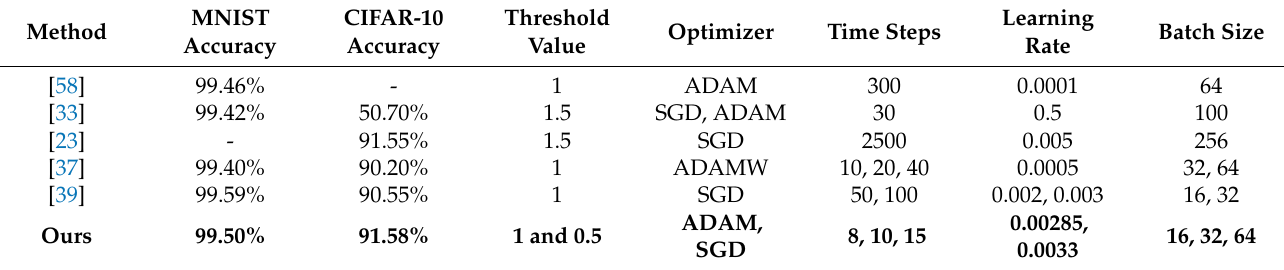
Table 6. Comparison of optimized parameters of our work with